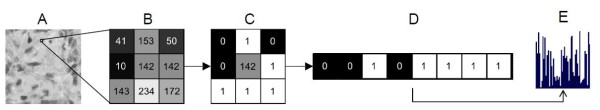
Local binary patterns (LBP) are defined for an image (A) based on its grayscale values. For every 3 × 3 pixel neighborhood (B) within the image, an LBP code is generated by thresholding the surrounding pixels using the value of the central pixel (C-D). A histogram (E) of the all LBP codes within the analyzed image is formed to represent texture properties of the image